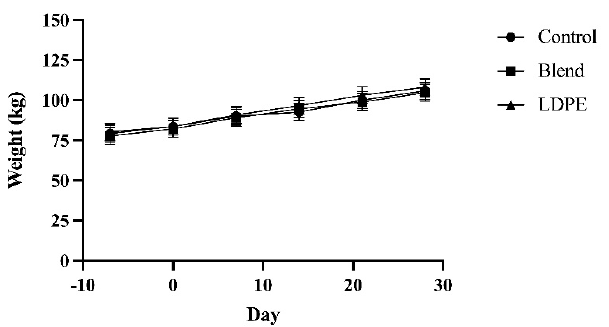
Figure 2. Weekly body weights of Holstein bull calves given Control, Blend, or LDPE treatments for 30 d. Treatment: p = 0.70. Day: p < 0.01. Treatment x Day: p = 0.15. Data are shown as least-squared means of treatments within time (LSM ± SEM).